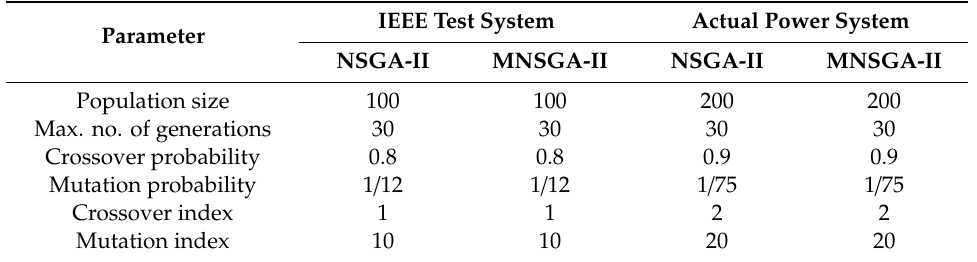
Table 10. Parameters used for non-dominated sorting genetic algorithm II (NSGA-II) and modified version of the NSGA-II